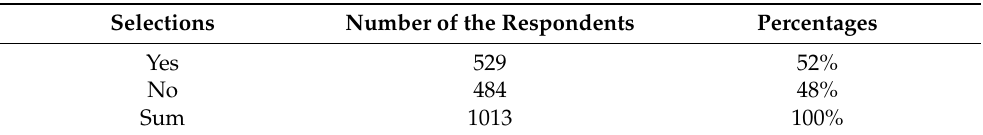
Table A19. Do you think that the trading of cryptocurrencies including Bitcoin in China should be legally permitted (single-choice question)?